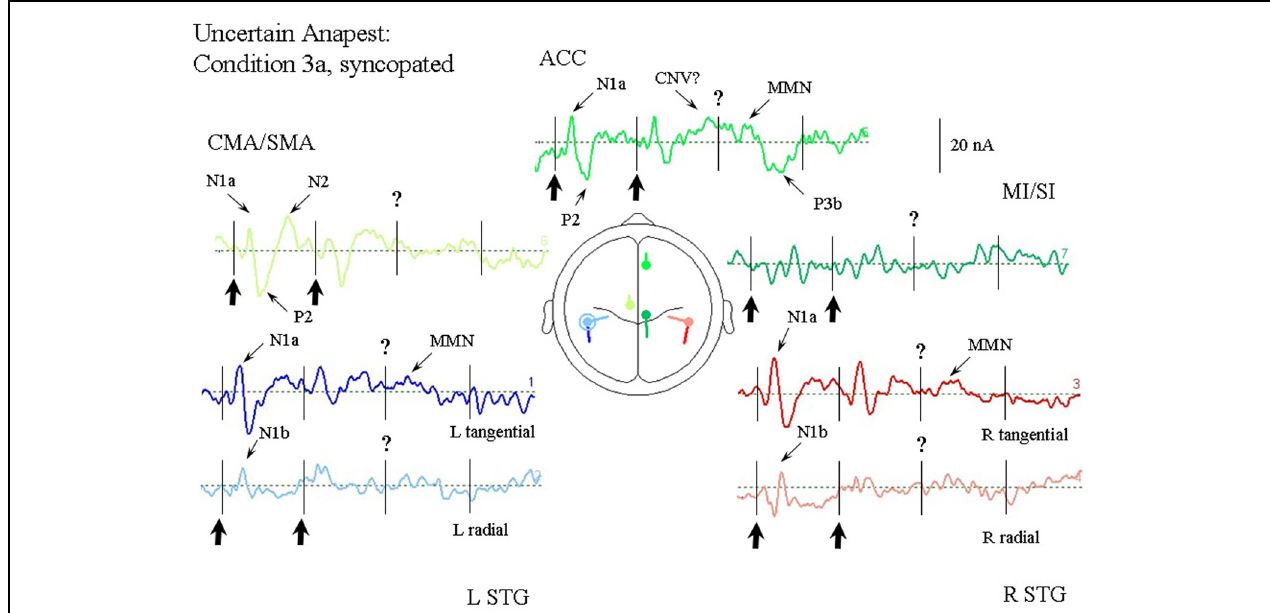
FIGURE 6 | Response of the optimum source model for passive listening to the syncopated anapest case (condition 3b). Beat onsets are indicated by vertical bars and click stimulus onsets by bold arrows. The uncertainty over the absent third click is indicated by a question mark. The presence of